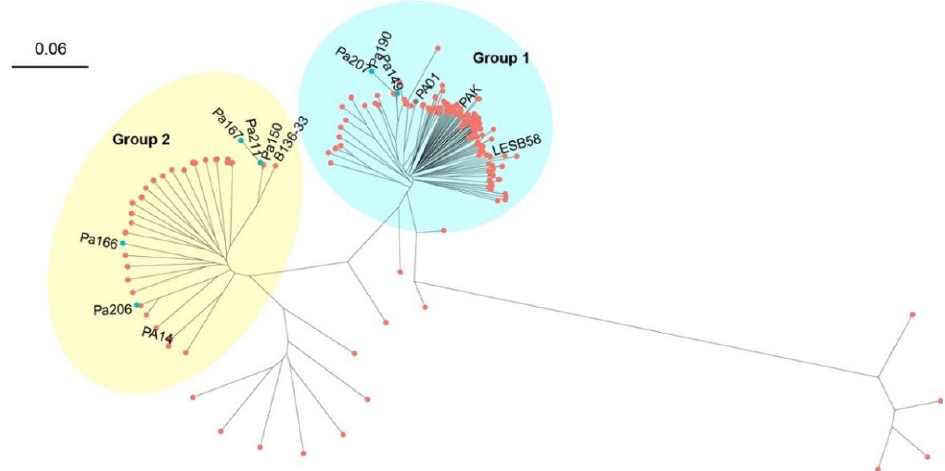
Figure 2. Phylogenetic tree of P. aeruginosa isolates constructed based on core-SNPs. Red nodes indicate the complete genomes obtained from the RefSeq database, whereas blue nodes indicate the genomes sequenced in this study.